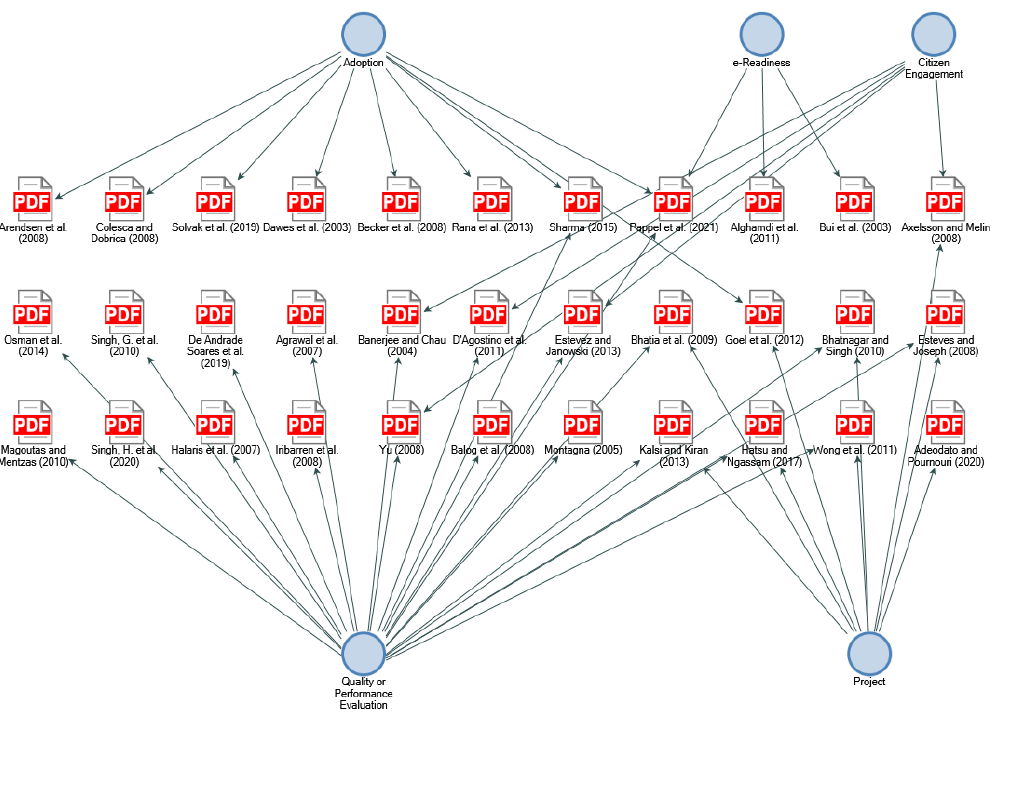
Figure 6: Association of Studies to the Themes